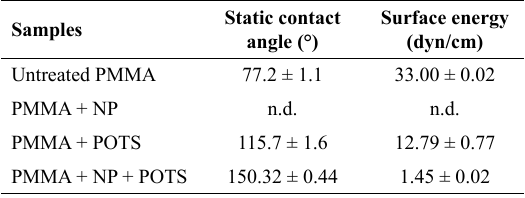
Table 1. Average apparent contact angle and surface energy of PMMA substrates subjected to surface treatment.